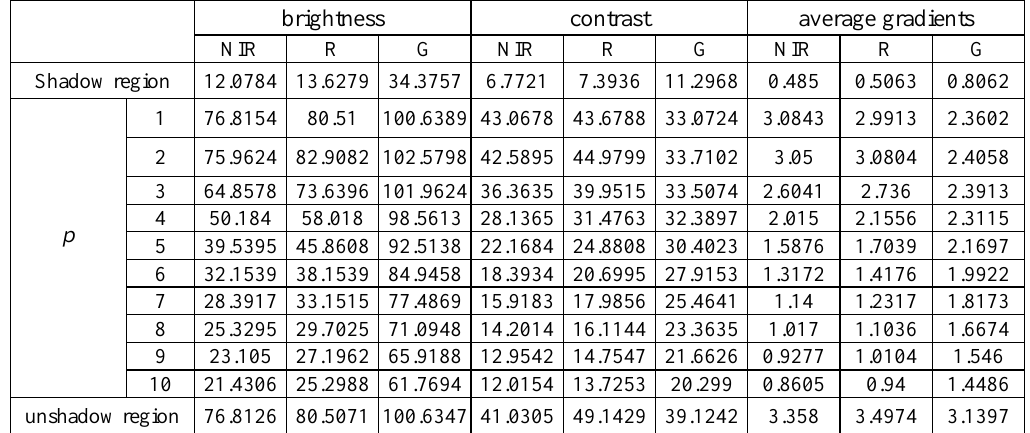
Table 2. The brightness, contrast, and average gradients of the color infrared aerial image before and after shadow